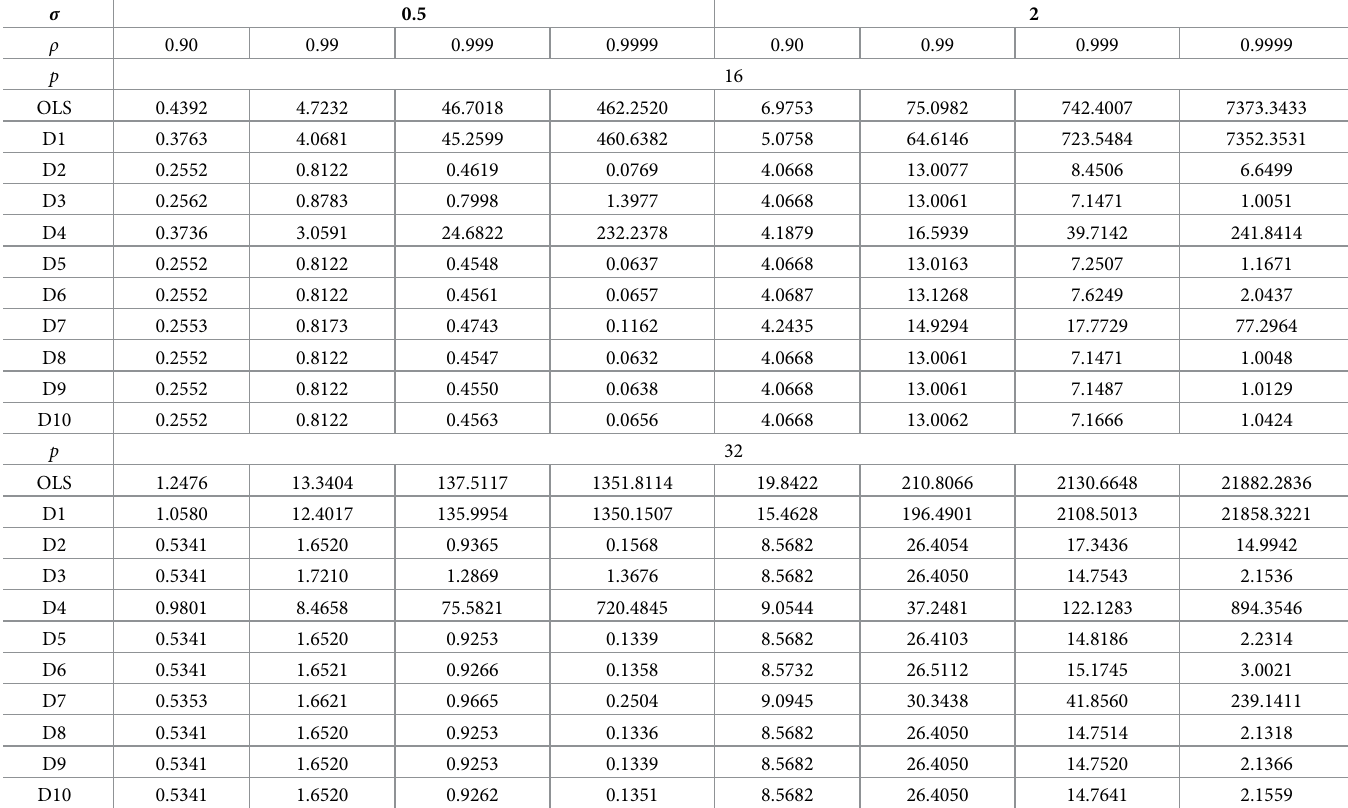
Table 3. EMSE with n = 100 and � ~ N (0, σ ).